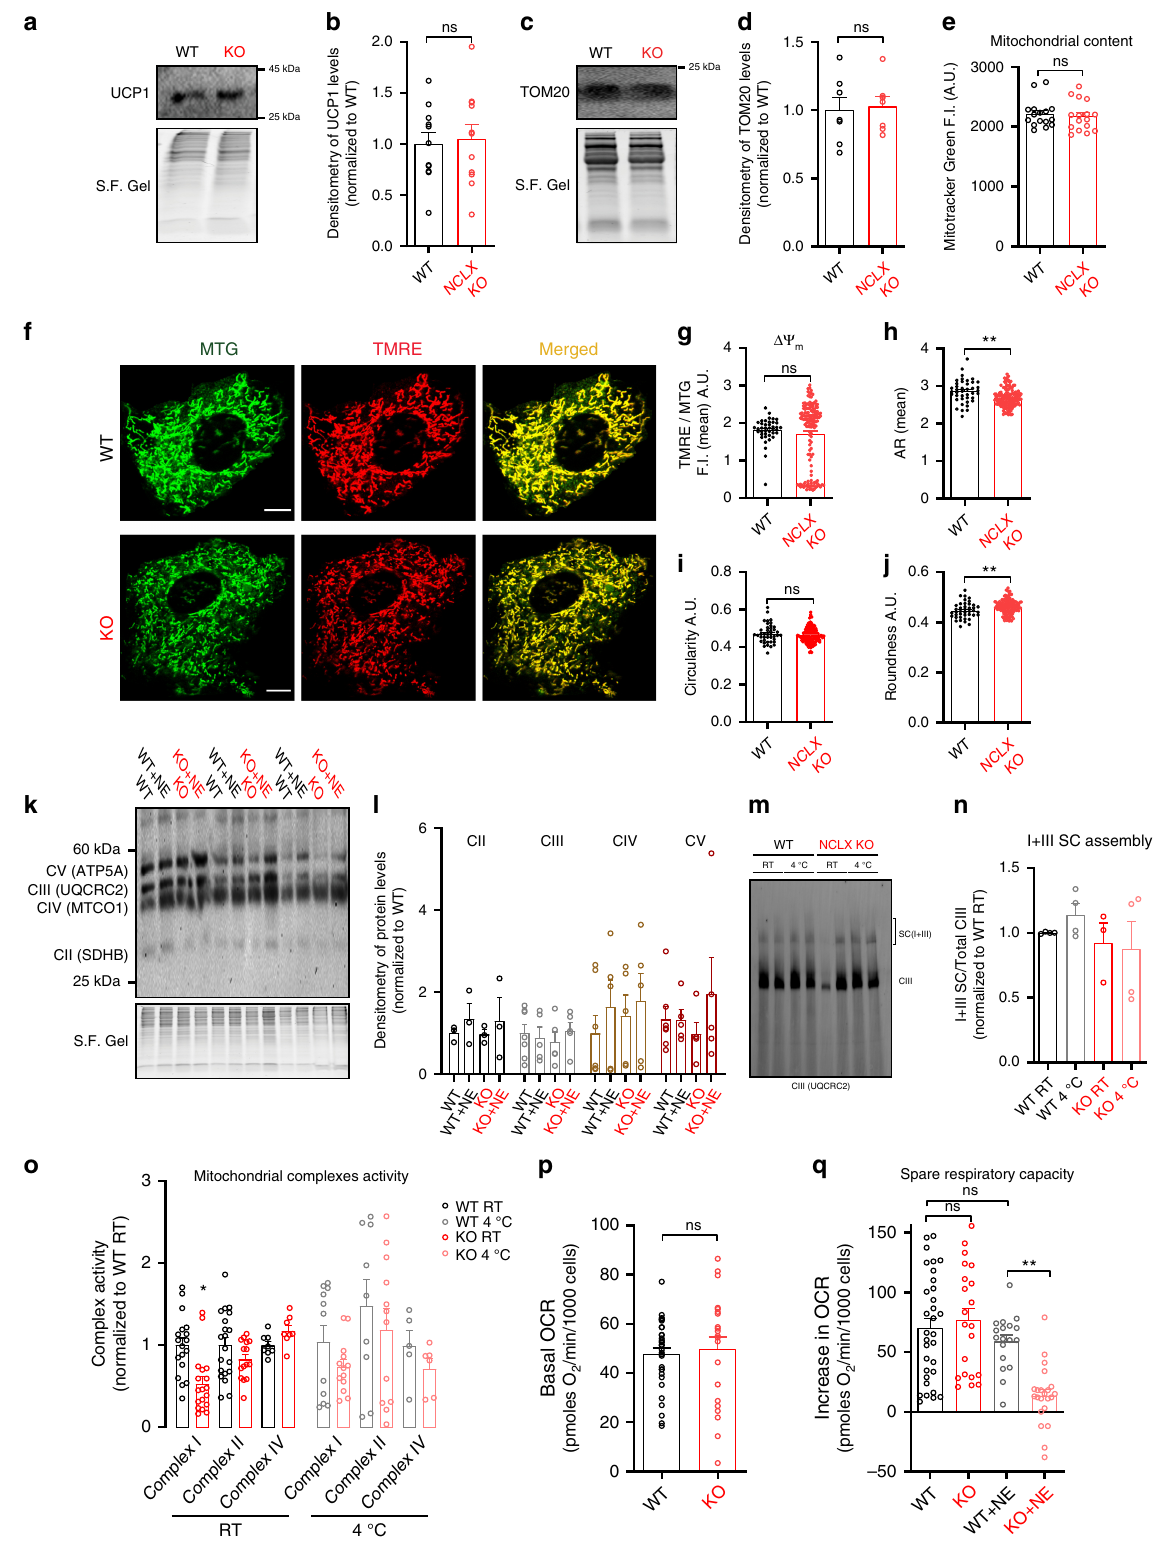
signi fi cant cellular death rates were observed in NCLX